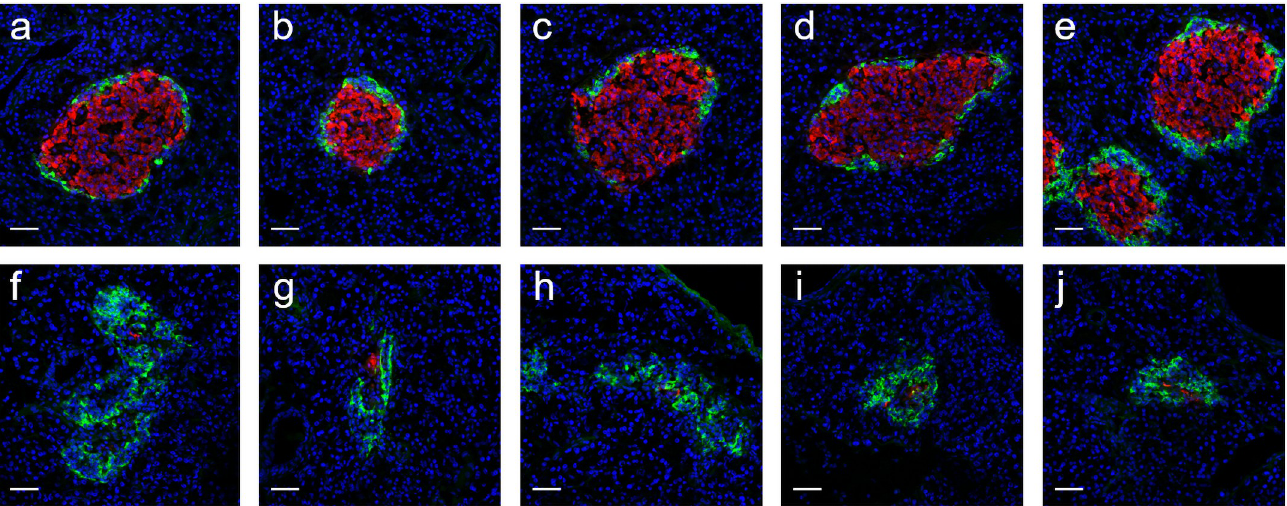
Fig 8. Representative images of islets from healthy and diabetic rats. Panels a-e (healthy) and f-j (diabetic) show frozen pancreas sections immunostained for insulin (red) and glucagon (green) to localize β - and α -cells, respectively. Pancreas sections (n = 3 for each condition) were processes for immunostaining using appropriate primary and secondary antibodies as stated in the Methods section. DAPI was used for nuclear staining (blue). Florescent images were obtained using a 40X objective in an Olympus FlowView confocal